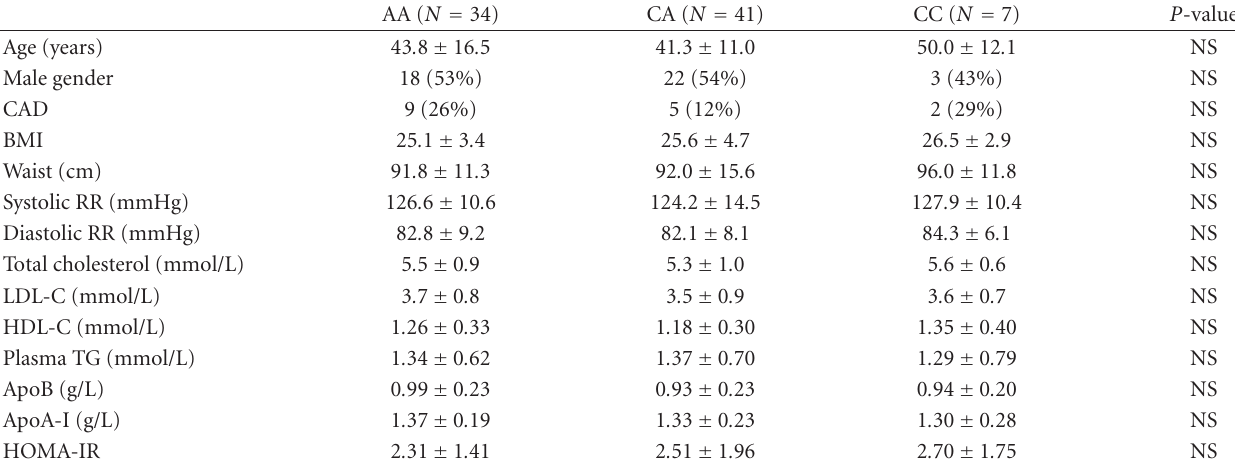
Table 1: Baseline characteristics for A1166C polymorphisms. Data are given as mean ± standard deviation unless stated otherwise.